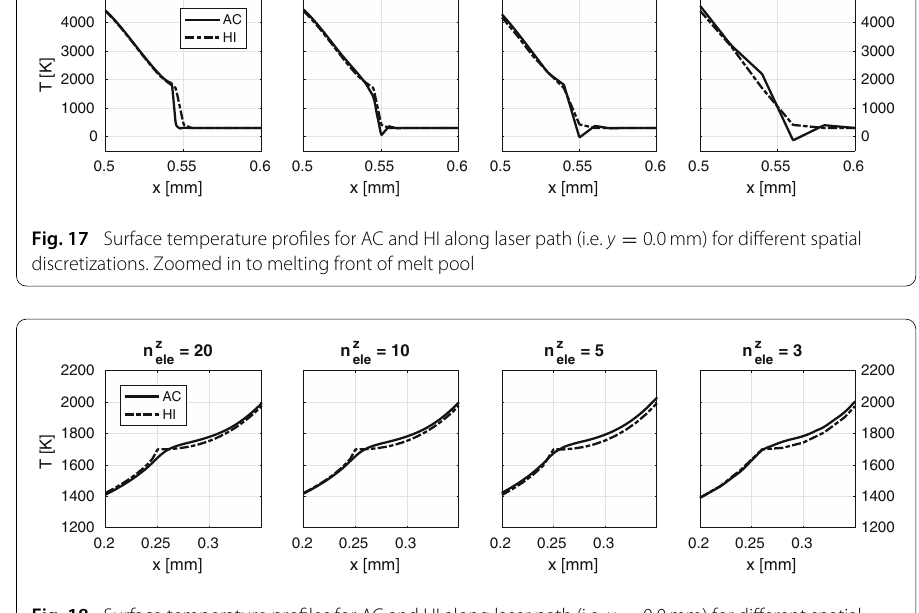
larger nonphysical oscillations in the temperature profile are observed for the AC